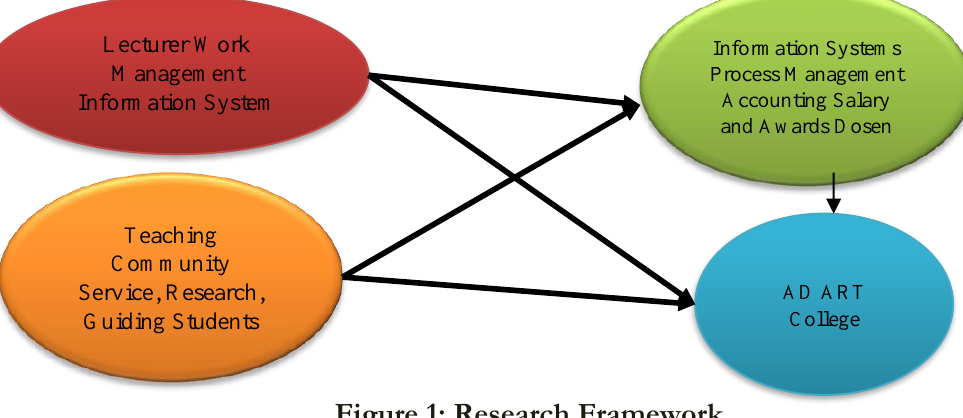
Figure 1: Research